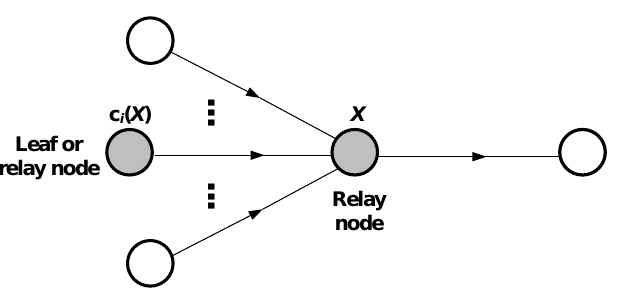
Figure 6. General scenario for the evaluation of the energy consumption per